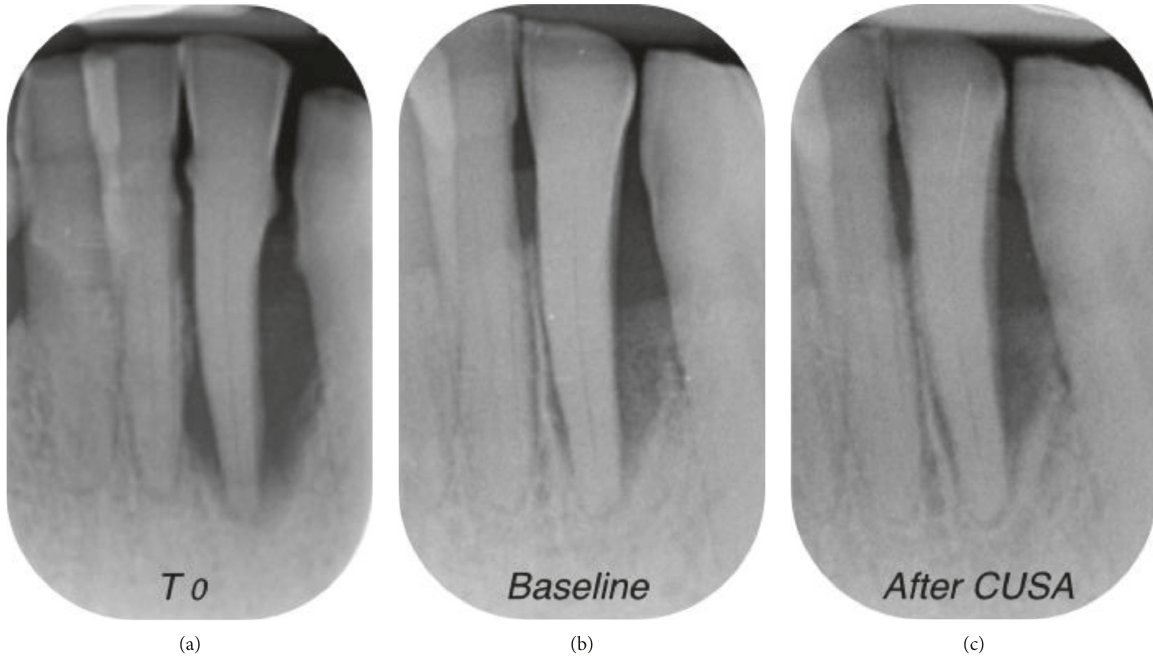
Figure 9: Progression of X-rays showing bone remineralization. Baseline is 12 months after (a) T0. In this case, the PD decreased from 10mm ((b) baseline) to 4mm (6 months (c) after CUSA). The CAL gain was 6 mm (from 14 mm to 8mm).